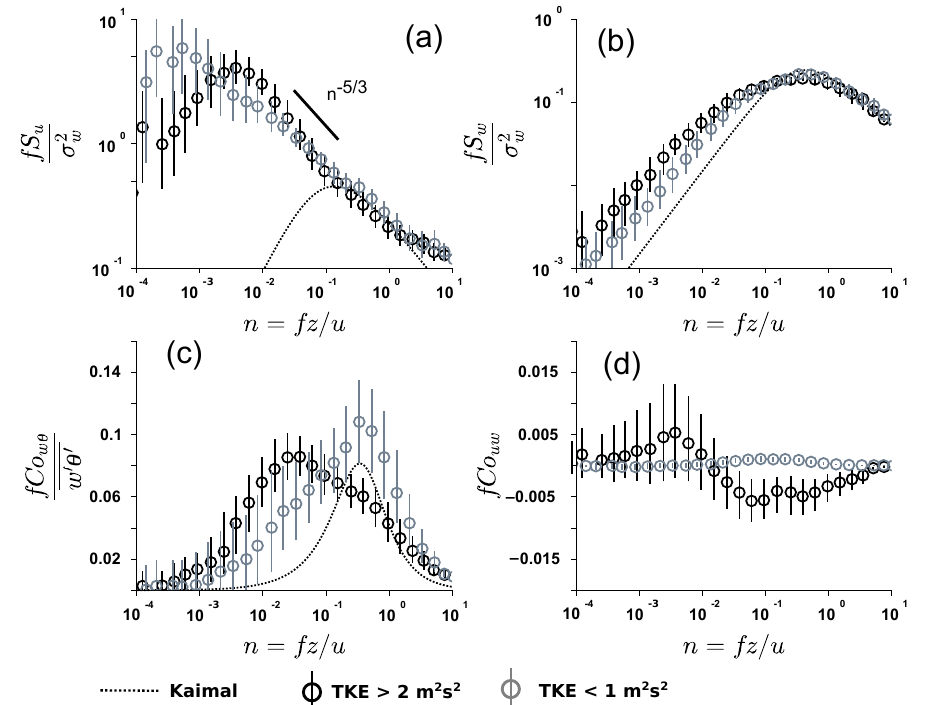
Figure 6. Fourier analysis of the high-frequency EC data during the 2006 campaign. The median spectra and cospectra calculated over (black) the strong forcing and high TKE and (grey) the weak forcing and low TKE subsets are presented together with (black dotted) the Kaimal et al. (1972) curve. (circles) Average of the spectra or cospectra over a bin of normalised frequency and (vertical bars) interquartile range of the spectra or cospectra over the same bin. (a) Spectra of horizontal wind speed u , (b) spectra of w , (c) cospectra of w with θ and (d) cospectra of w with u